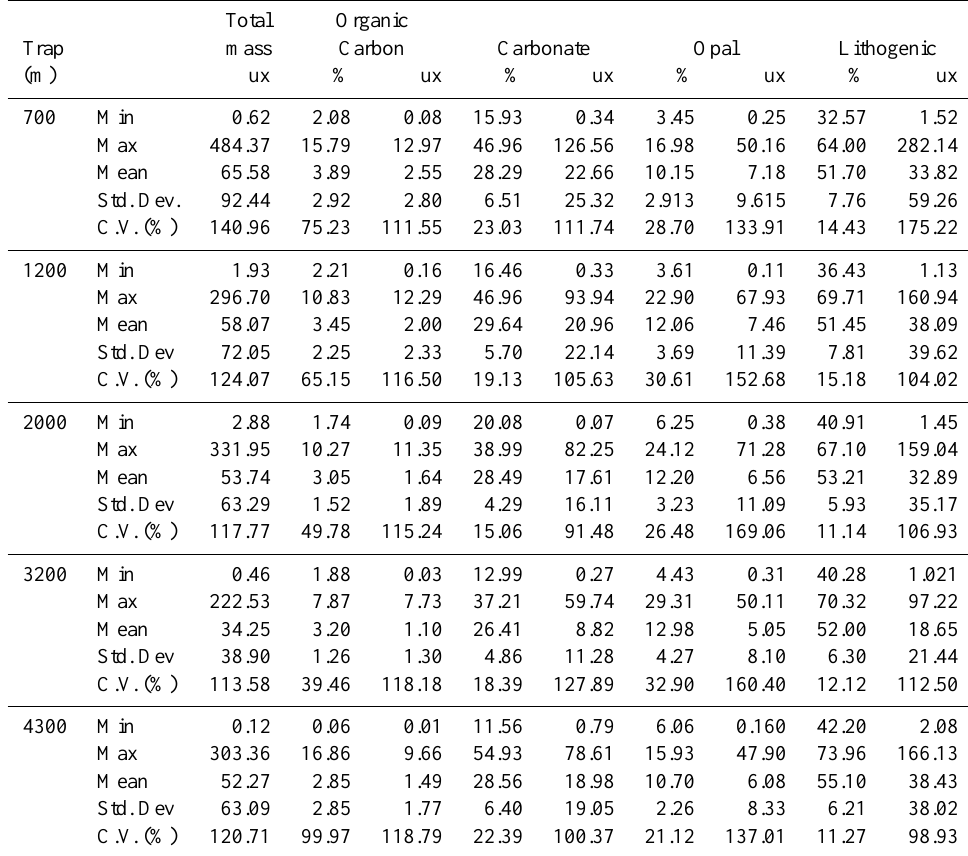
Table 1. Descriptive statistics of total mass and main constituent fluxes (mgm − 2 day − 1 ) , and contribution (%) of main constituents to total mass for the different traps. Mean corresponds to time-weighted mean fluxes and flux-weighted